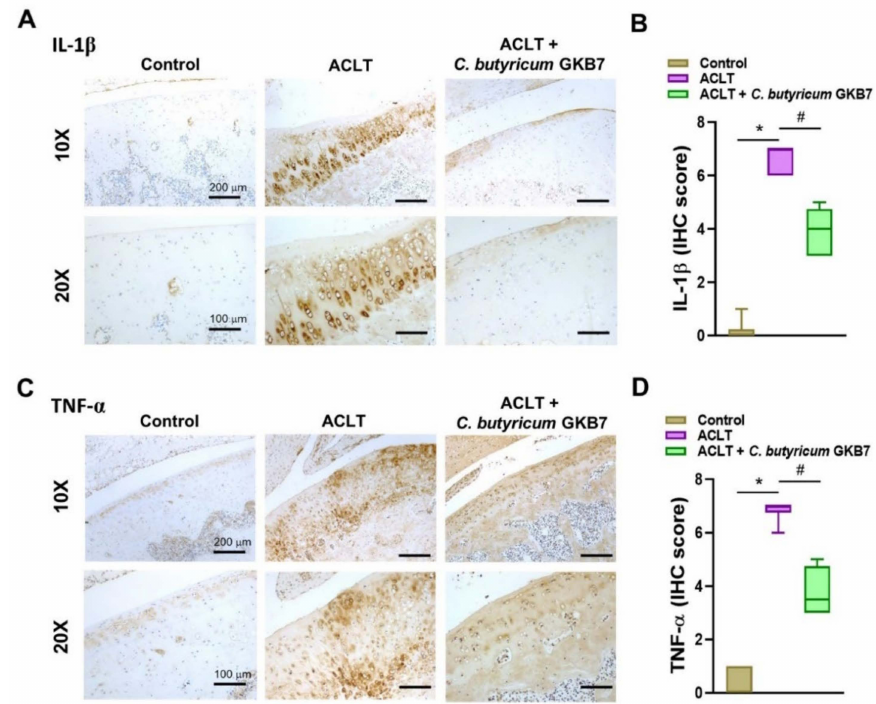
Figure 5. Oral C. butyricum GKB7 downregulates IL-1 β and TNF- α in OA articular cartilage. Im- munohistochemistry analysis and scoring of IL-1 β ( A , B ) and TNF- α ( C , D ) in right knee joint cartilage.